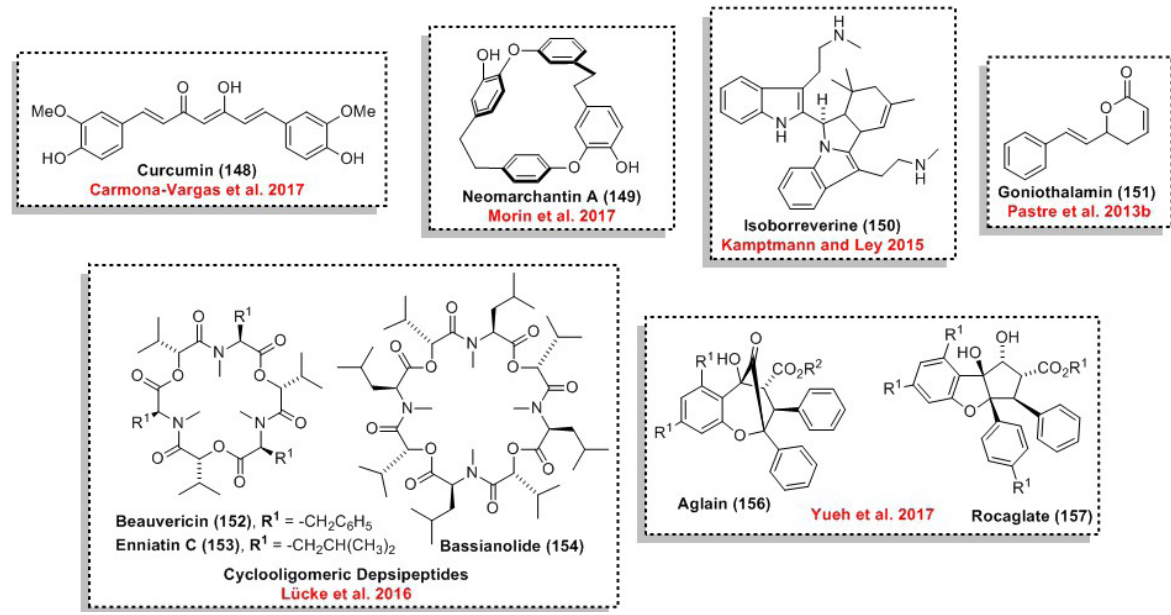
Figure 7 - NPs prepared using batch and flow integrated approaches, since